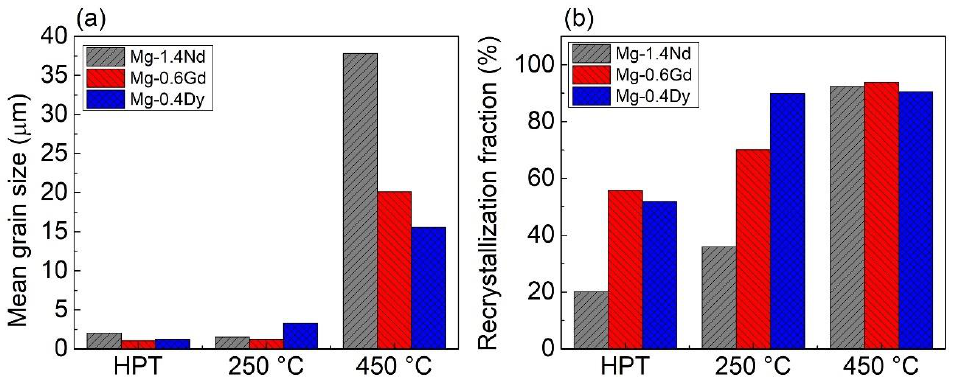
Figure 3. Evolution of: ( a ) mean grain size and ( b ) recrystallisation fraction of HPT-processed and annealed Mg-1.4Nd, Mg-0.6Gd, and Mg-0.4Dy alloys at 250 and 450 °C for 1 h, respectively. The histograms of the grain boundary misorientations are shown in Figure 4 for the HPT-processed and annealed Mg-1.4Nd, Mg-0.6Gd, and Mg-0.4Dy alloys at 250 and 450 °C for 1 h, respectively. These grain boundary misorientation angle distributions are far from the random distribution for all Mg – RE samples. A distinct change in the grain boundary distribution is noticeable in the Mg-1.4Nd alloy after annealing at 450 °C whereas the grain boundary distributions were similar for the Mg-0.6Gd and Mg-0.4Dy alloy throughout the HPT processing and annealing treatments. Both the deformed and annealed alloys exhibited a peak maximum of around 30°, indicating the develop- ment of a 30° <0001> misorientation relationship which is commonly observed during growth of recrystallised grains in hexagonal alloys [69 – 71]. Figure 4. Grain boundary misorientation angle distributions and fractions of VLAGBs, LAGBs, and HAGBs of samples HPT-processed and annealed at 250 and 450 °C for 1 h: ( a ) Mg-1.4Nd, ( b ) Mg- 0.6Gd, and ( c ) Mg-0.4Dy alloys.